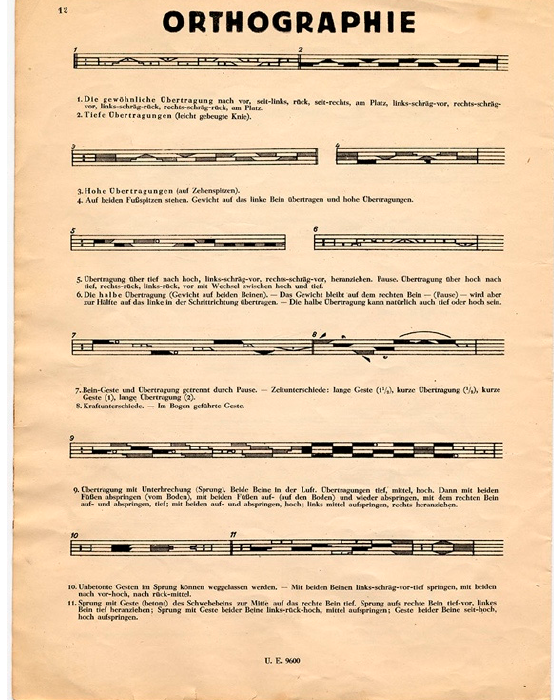
Figure 9. Excerpt from Rudolf von Laban’s journal Schrifttanz , volume 1. Vienna: Universal Edition, 1928.